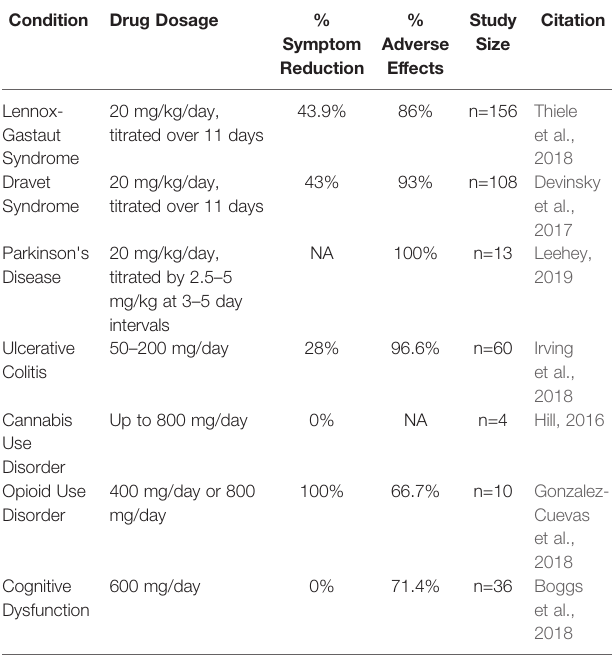
TABLE 1 | Clinical trial results from epidiolex-focused studies. Condition Drug